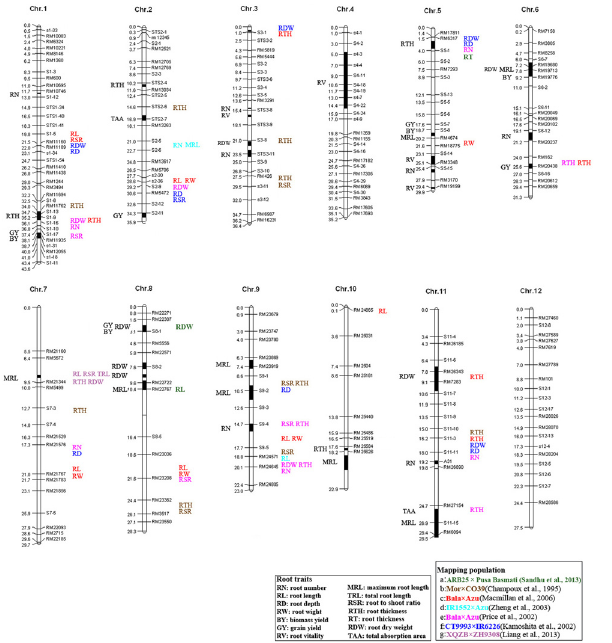
Fig 2. Bin allocations on the rice molecular linkage map of the QTLs identified in this study and other nine mapping populations evaluated for root traits. Acronyms on the left of the chromosomes represent QTLs identified in this study and acronyms to the right of the chromosomes represent QTLs identified in the other nine mapping populations. Vertical parentheses spanning two bins indicate QTLs that could not be assigned to a single bin. The colors of acronyms for root traits represent the nine populations in which such traits were